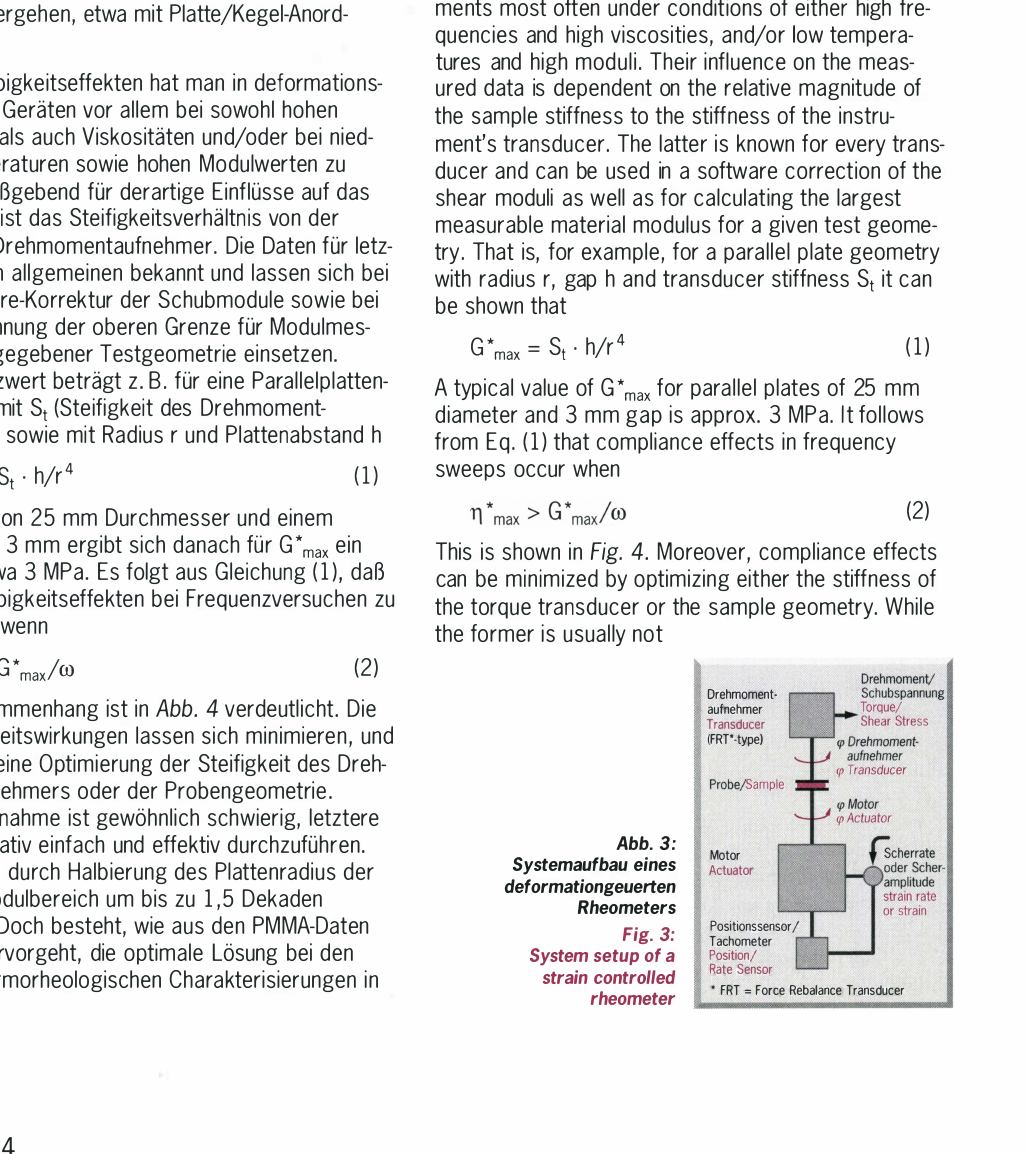
Fig. 3: System setup of